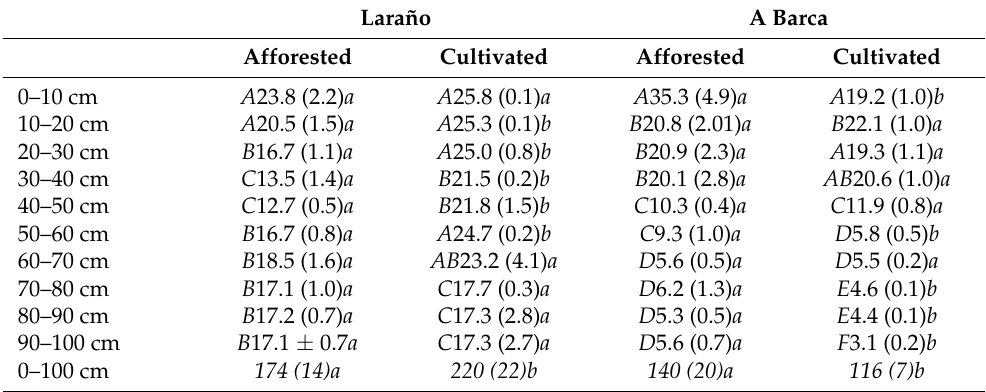
Table 6. C contents (Mg C ha − 1 ) at the different soil depths (mean and standard deviation, in brackets). For each soil (use and site), different capital letters indicate significantly different mean values at the different depths ( p < 0.01); for both soils in the same site the values of the C contents followed by lowercase letters are significantly different at the same depth ( p <